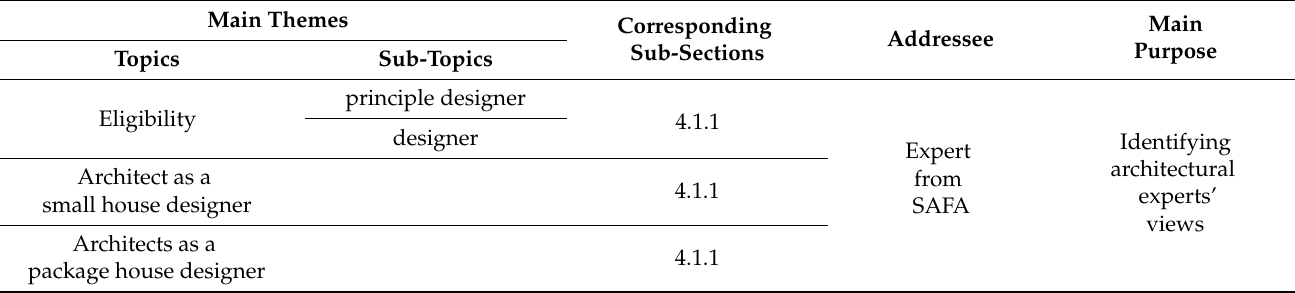
Table 3. The main themes, addressee, and main purpose of the interview questions (Appendix